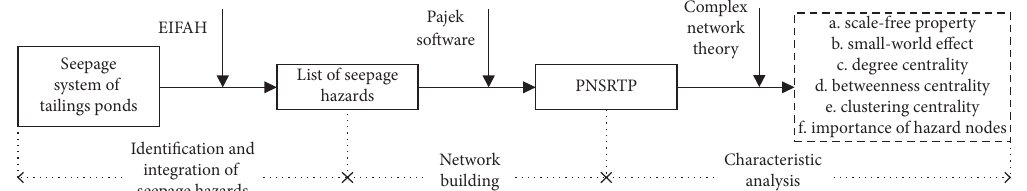
Figure 1: The flow chart of research methods and